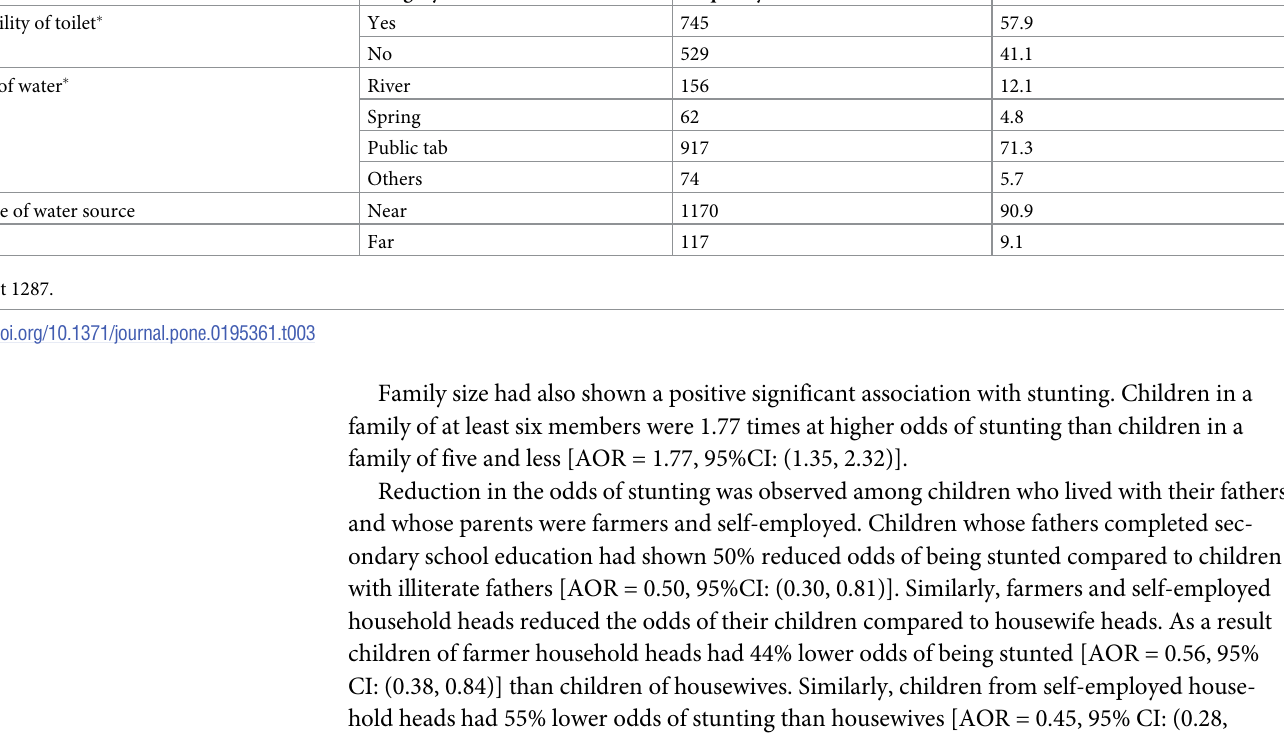
Table 3. Environmental health conditions of households in Libo-kemekem district, northwest Ethiopia. Characteristics